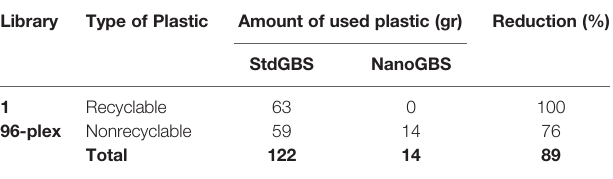
TABLE 3 | Estimated amount of disposable plastic usage in one 96-plex genotyping-by-sequencing (GBS) experiment using standard GBS (StdGBS) and NanoGBS